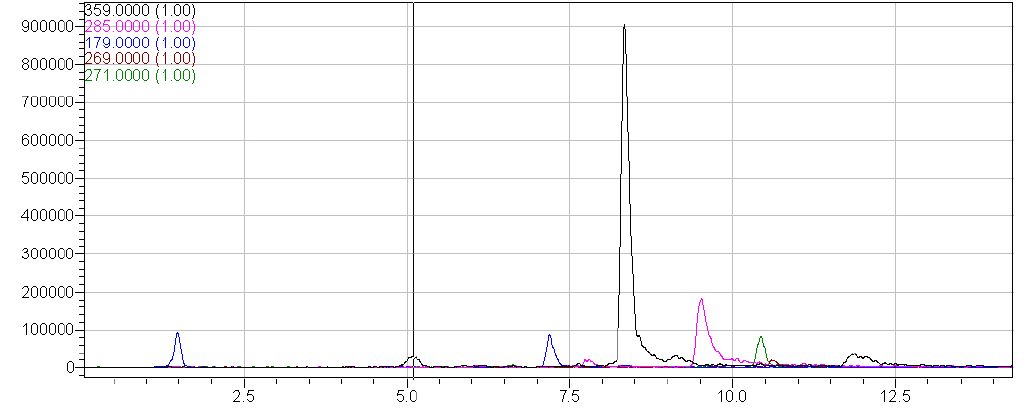
Figure 4. LC-MS (scan) chromatogram of the analyzed extract from the irradiated